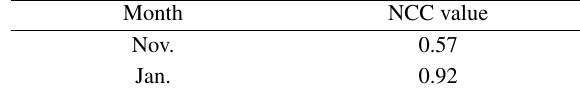
Table 17 NCC value between the Arabic tweets (classified as self and nonself) and count of actual hospital visits.